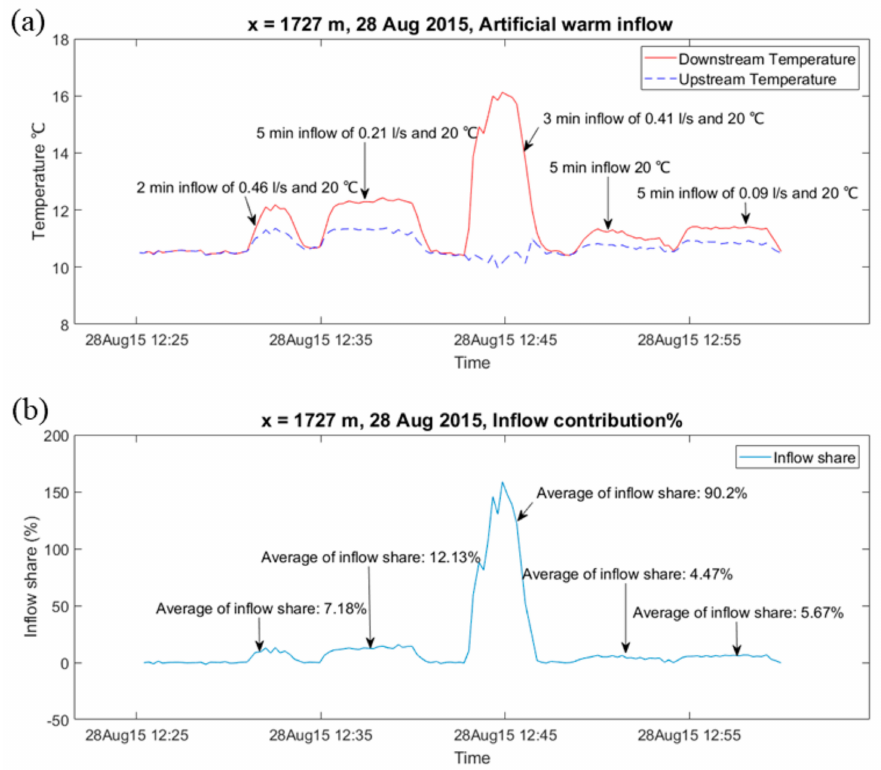
Figure 5. ( a ) Upstream and downstream temperatures on 28 August 2015 around warm artificial discharge in location x = 1727 m; ( b ) percentage of inflow share in comparison with the upstream